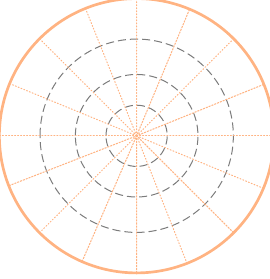
Figure 1. Schematic diagram of the point coverage grid method.